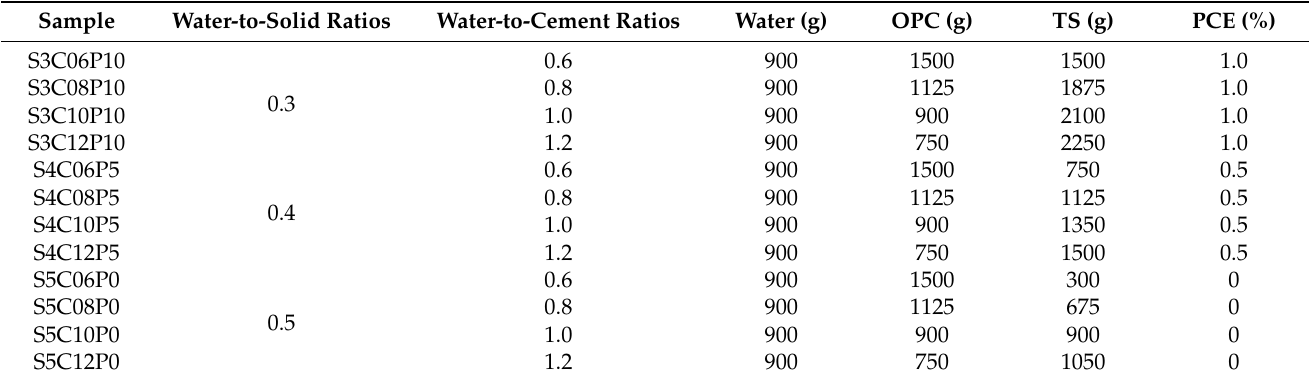
Table 2. Mixture proportions of